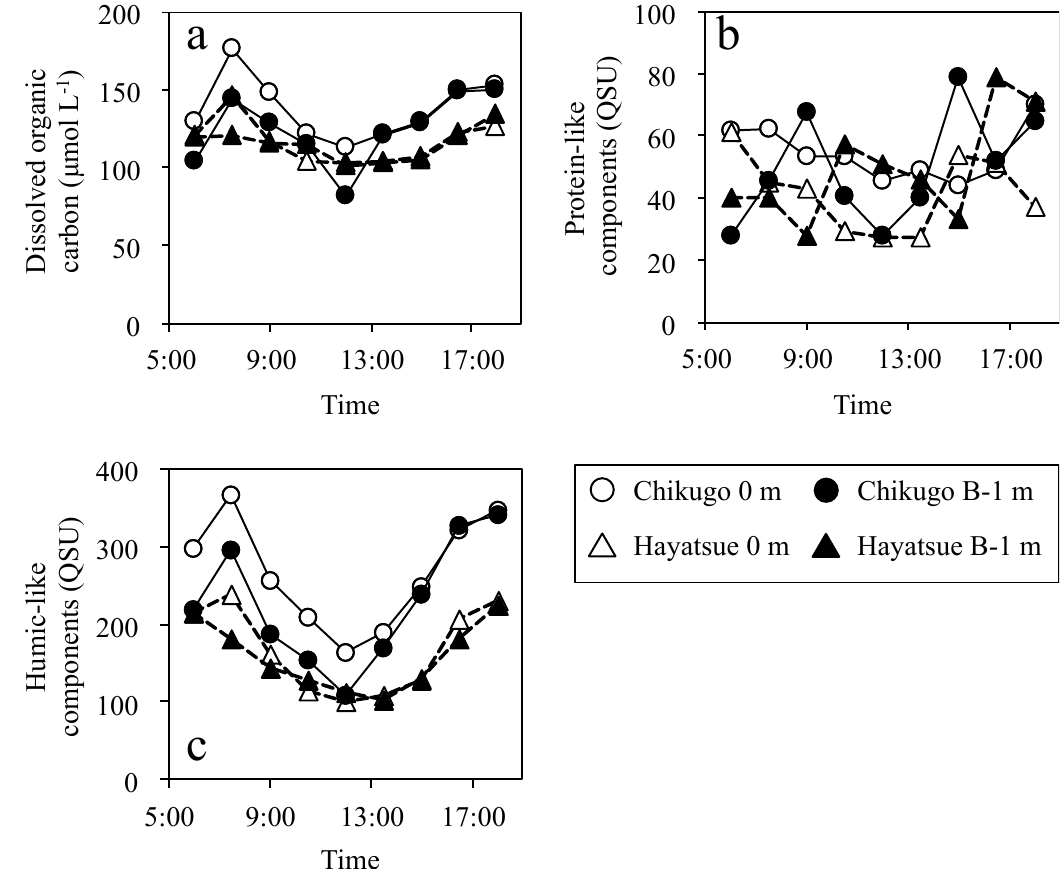
Figure 6. Variations in the ( a ) dissolved organic carbon (DOC) concentration, ( b ) protein-like component, and ( c ) humic-like component during the sampling period.